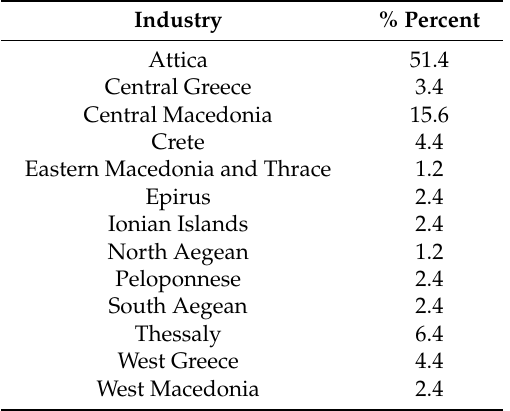
Table 3. Examined firms’ geographical